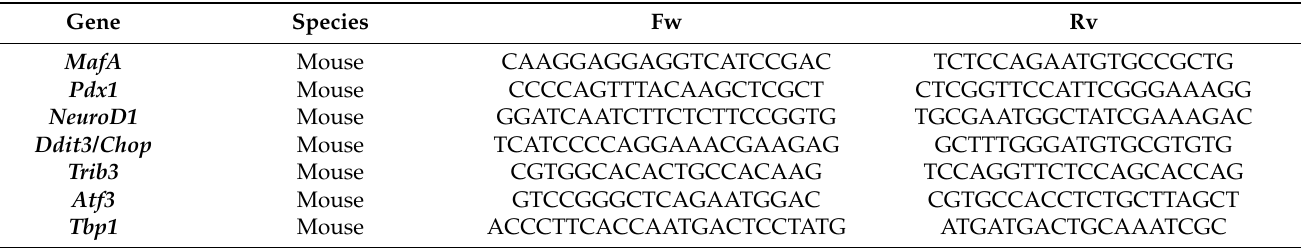
Table 1. Primer sequences used for gene expression analysis for